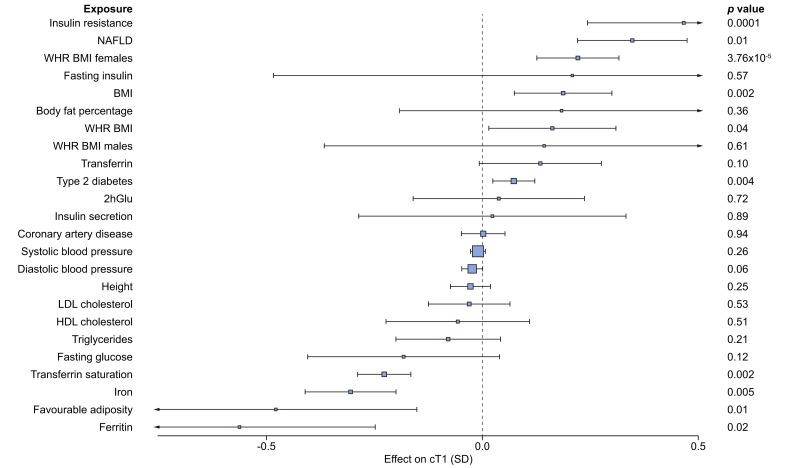
Mendelian randomisation investigating the effect of 24 predominantly metabolic traits on liver cT1.We used 2-sample Mendelian randomisation analysis to investigate the causal effects of metabolic traits on liver cT1. For full results, including sensitivity analyses, please see Table S4. The inverse variance weighted test was used as the main analysis. Levels of significance: p <0.05. 2hGlu, 2 hour glucose tolerance test; cT1, corrected T1; NAFLD, non-alcoholic fatty liver disease; WHR_BMI, waist hip ratio adjusted for BMI.